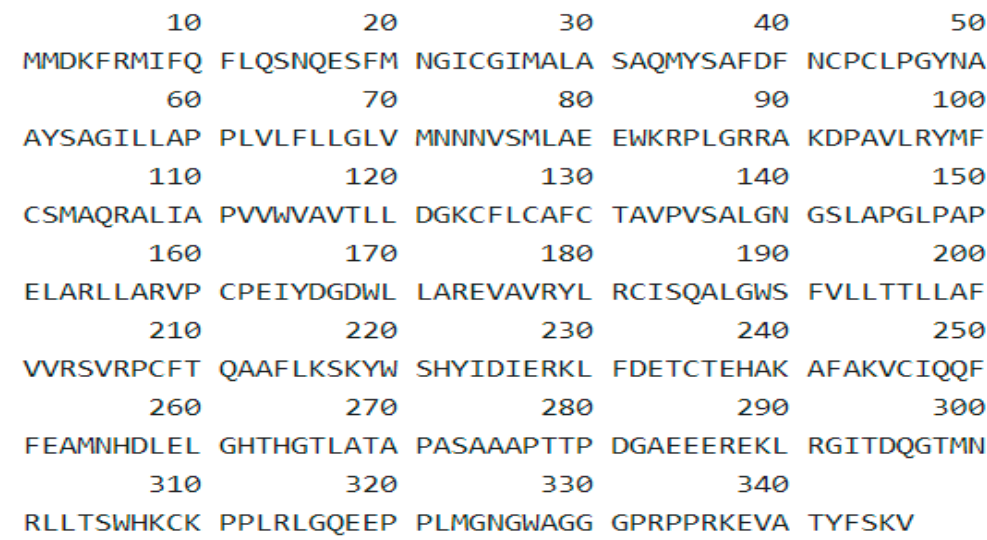
Figure 1. Protein sequence of CALHM1.